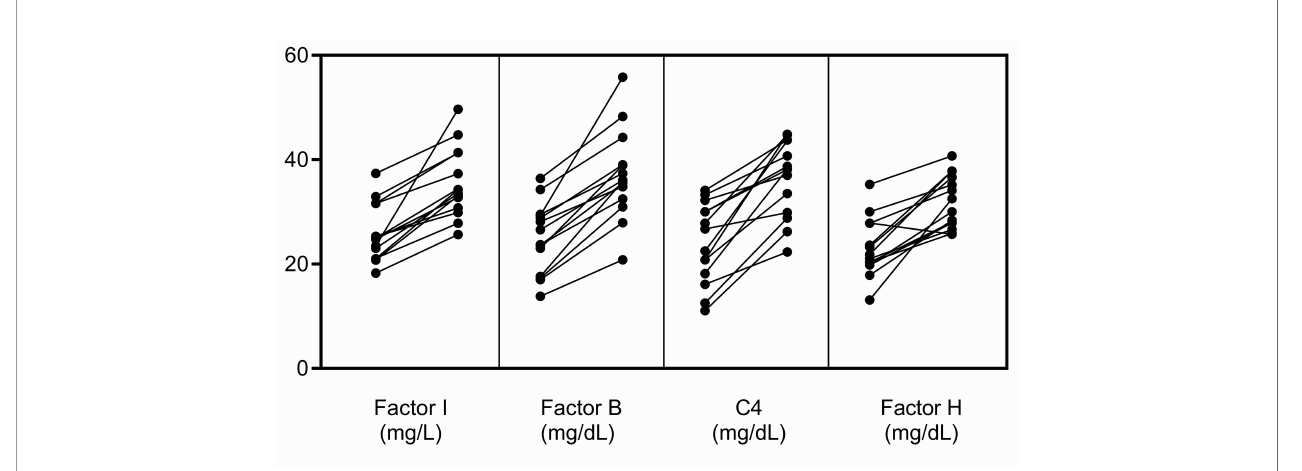
Supplementary Table 1 | Biomarker data in patients with aHUS. Supplementary Table 2 | Biomarker data in patients with